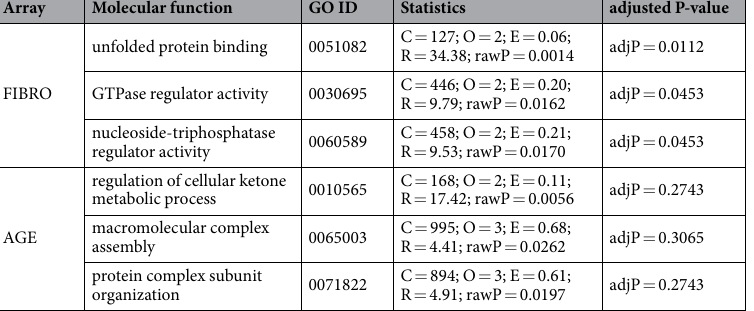
Table 2. Functional enrichment analysis of genes overlapping de novo CNVs. Where C = number of reference genes in the category, O = observed number of genes in the gene set from the category, E = expected number in the category, R = Ratio of enrichment, rawP = p value from hypergeometric test, adjusted p-value = p value adjusted by the multiple test adjustment.